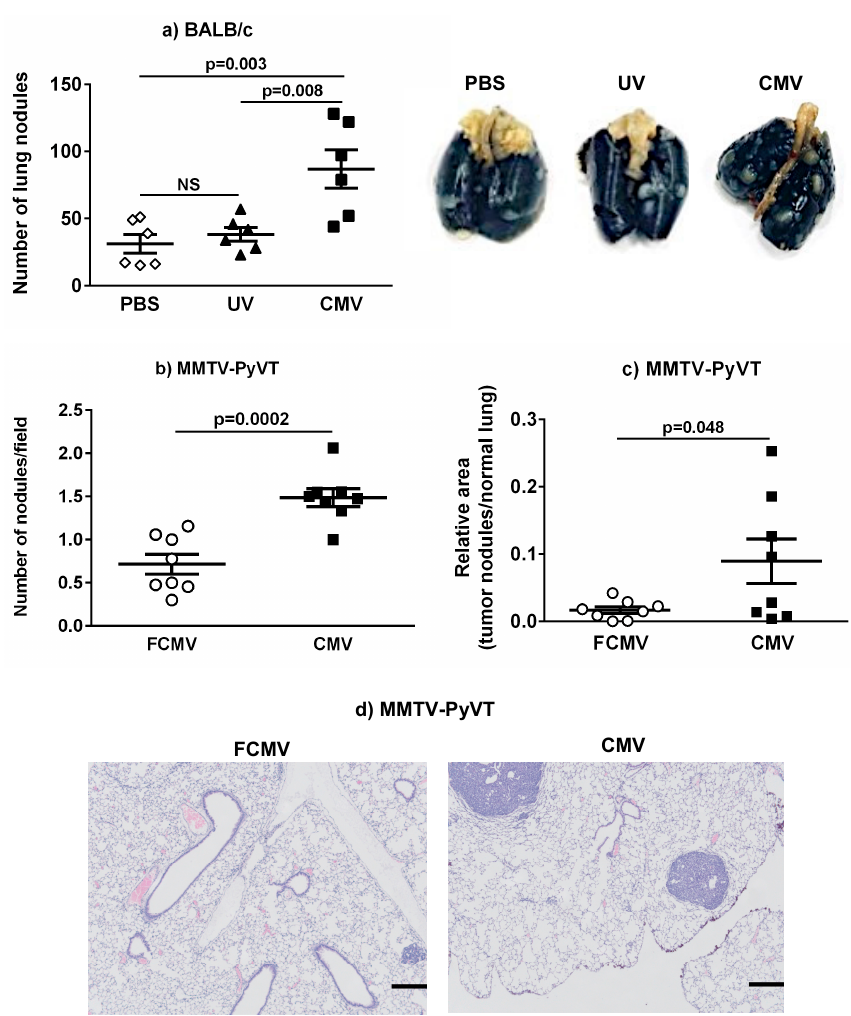
Figure 4. Lung metastasis was increased in mice latently infected with mCMV. The number of large lung nodules in the BALB/c model (n = 6) were quantified, and the representative lungs were depicted ( a ). Lung micro-metastasis in the MMTV-PyVT model (n = 8) was assessed by staining with hematoxylin and eosin and analyzed as the number of nodules per microscopic field at 5 × magnification ( b ) and the area of nodules per lung area ( c ). The representative stained lung sections from the mice treated with a filtered control solution (FCMV) or mCMV with a 5 × magnification lens are shown ( d ). Scale = 280 µ m. The p -values were calculated by a one-way ANOVA (Figure 4a) or Student’s t -test (Figure 4b,c). NS = not significant.